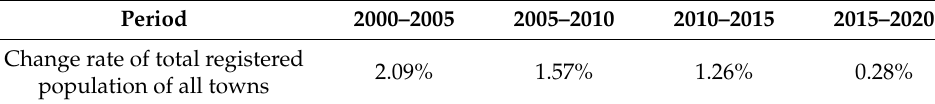
Table 8. Change in total registered population of all towns during each time